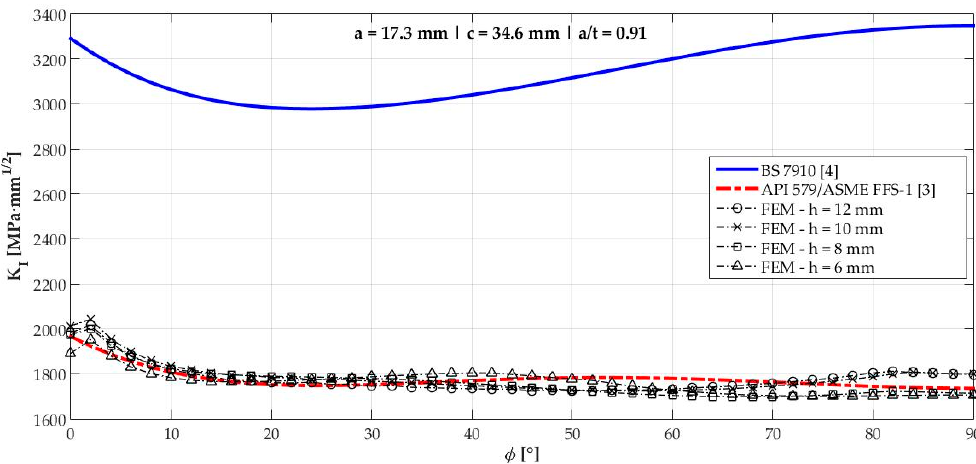
Figure 17. Mode I SIF profiles for crack 12 ( a = 17.3 mm , c = 34.6 mm , and a/t = 0.91 ).